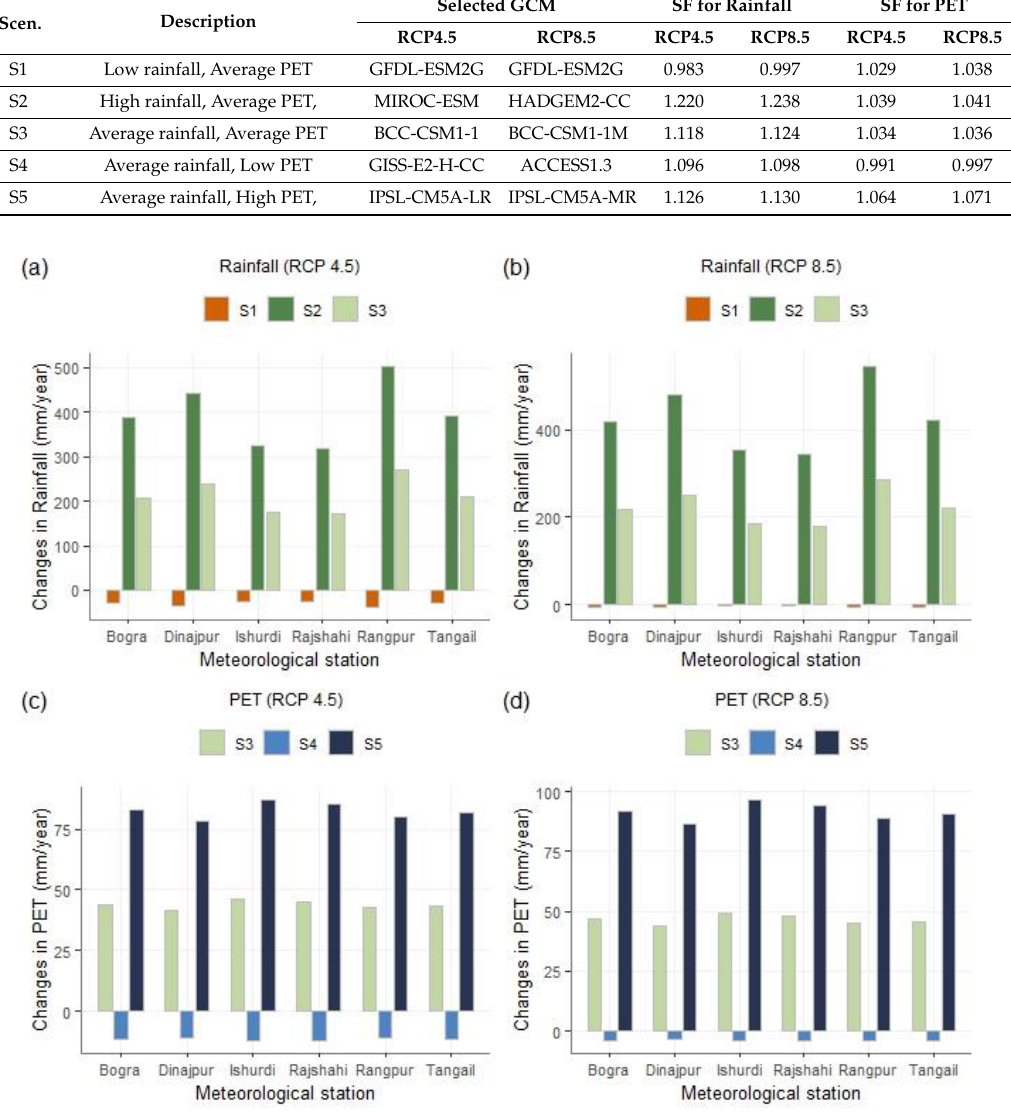
Figure 11. Projected changes in rainfall ( a , b ) and PET ( c , d ) at six meteorological stations in the northwest region of Bangladesh for the five scenarios (S1 to